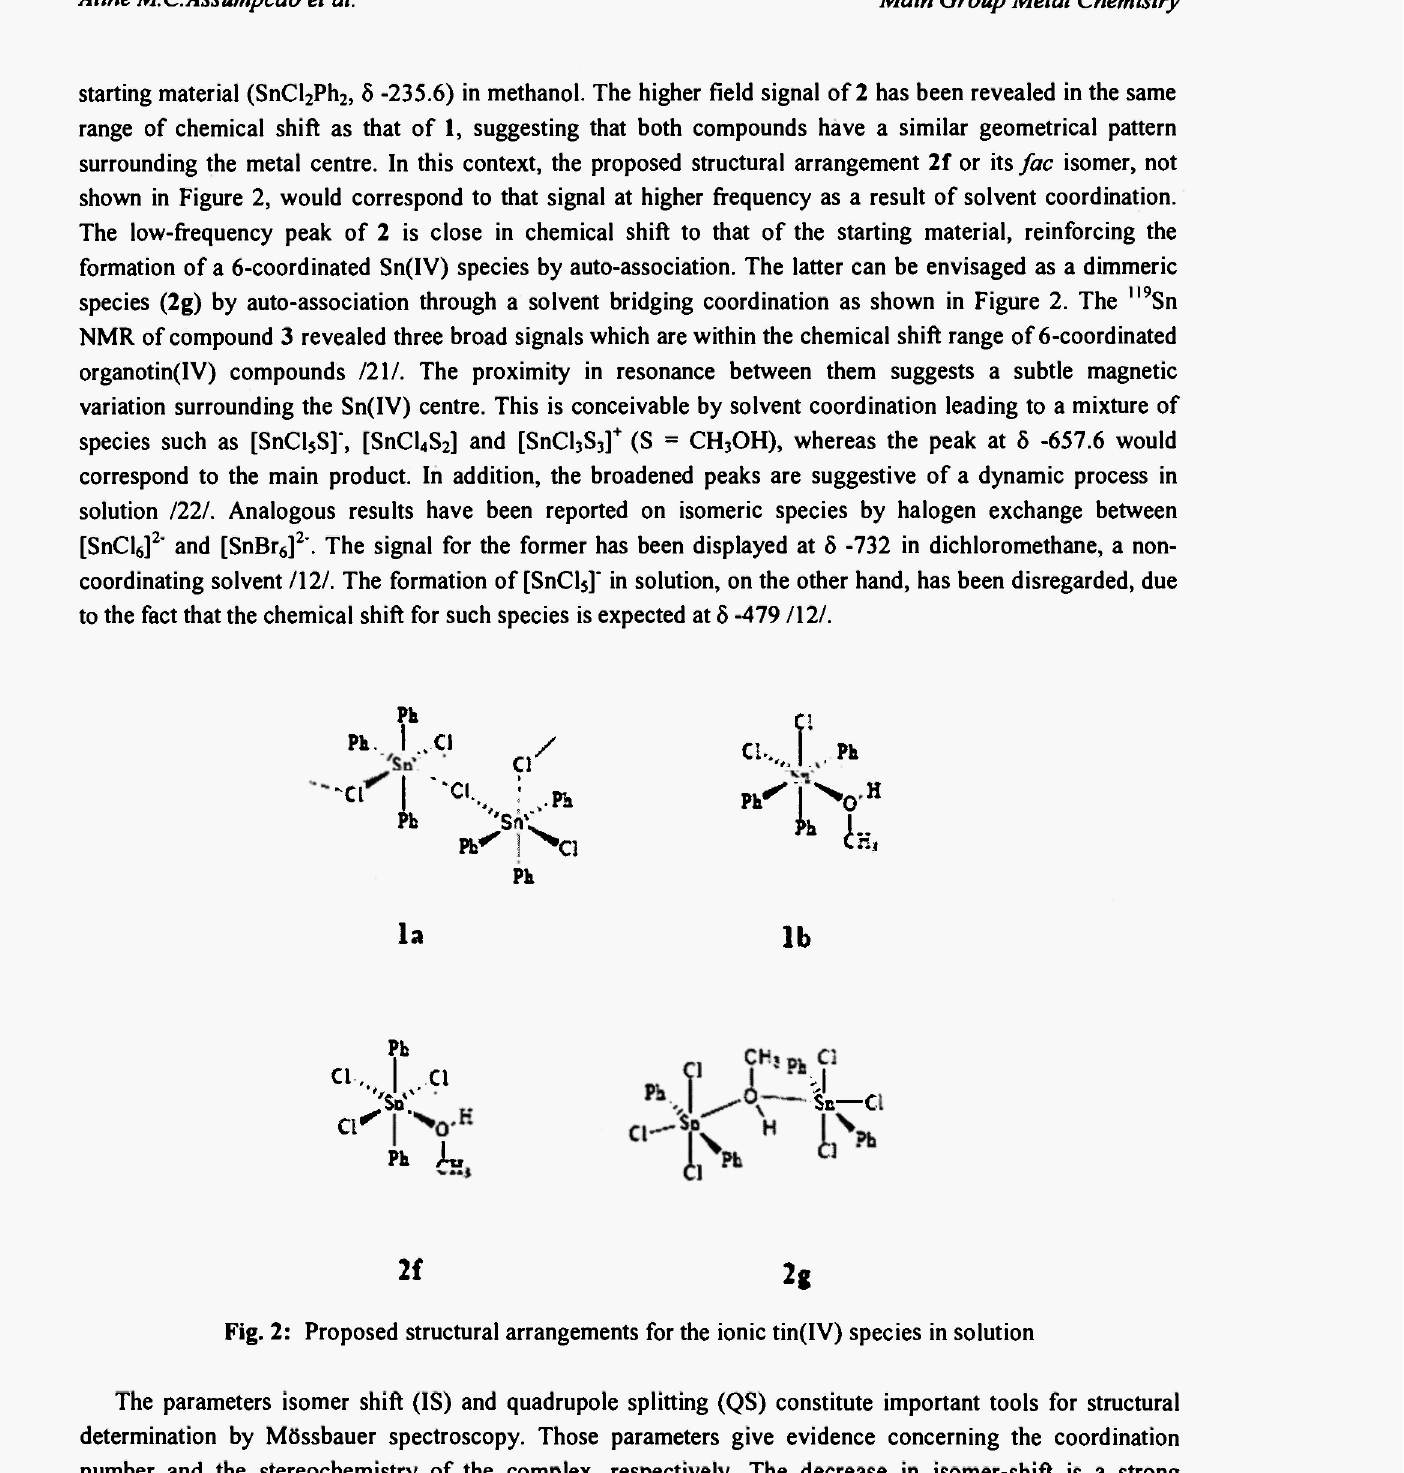
Fig. 2: Proposed structural arrangements for the ionic tin(IV) species in